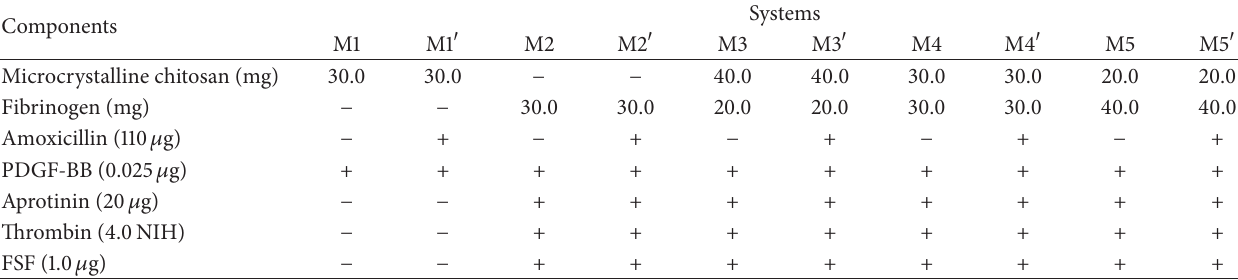
Table 1: Component of fibrin, microcrystalline chitosan, and fibrin-microcrystalline chitosan membrane systems. Components Microcrystalline chitosan